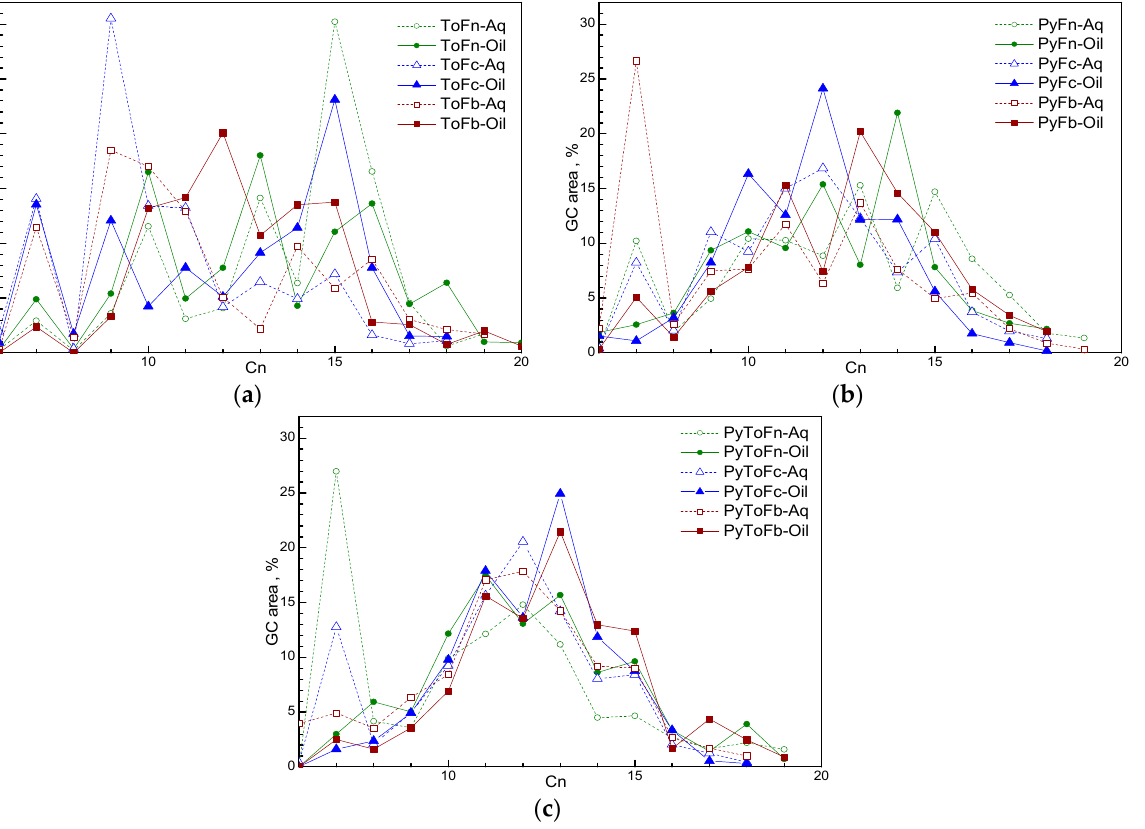
Figure 8. The NP-gram curves of aqueous and oil fractions from thermal processing of needles, cones and bark from fir by torrefaction ( a ), pyrolysis ( b ) and combined torrefaction+pyrolysis ( c ).